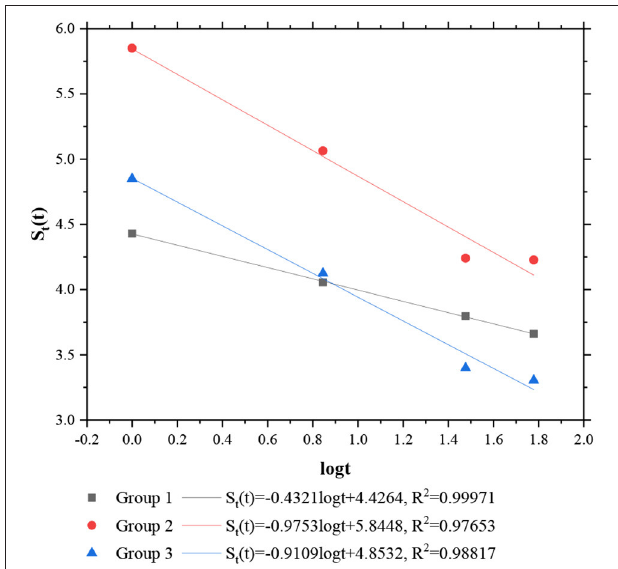
FIGURE 7 | Relationship between thixotropic sensitivity S t ( t ) and log t .